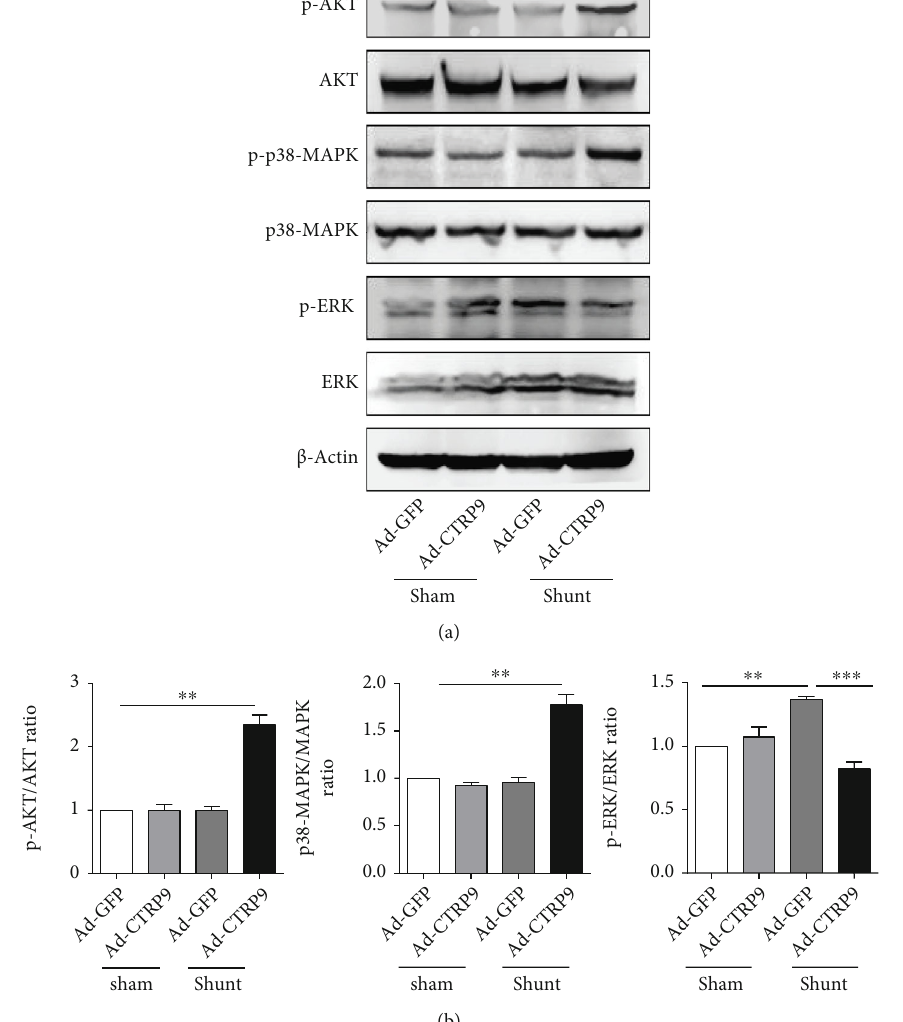
Figure 5: CTRP9 activates AKT signaling to relieve PAH in vivo . (a) Following the systemic delivery of Ad-CTRP9 or Ad-GFP, the wild- type rats were subjected to shunt or sham operation. CTRP9 promoted AKT, MAPK, and ERK phosphorylation during PAH. (b) The relative levels of phosphorylated AKT, p38-MAPK, and ERK were quanti fi ed using ImageJ and are expressed relative to the β -actin signal. The data are expressed as the mean ± SEM . n = 6 for each group. A total of 6 samples were randomly selected from each group to perform western blotting. ∗∗ P < 0 : 01 and ∗∗∗ P < 0 : 001 vs. the Ad-GFP-sham group. CTRP9: C1q/TNF-related protein 9; PAH: pulmonary arterial hypertension; Ad-CTRP9: adenovirus-CTRP9; p38-MAPK: p38-mitogen-activated protein kinase; ERK: extracellular regulated protein